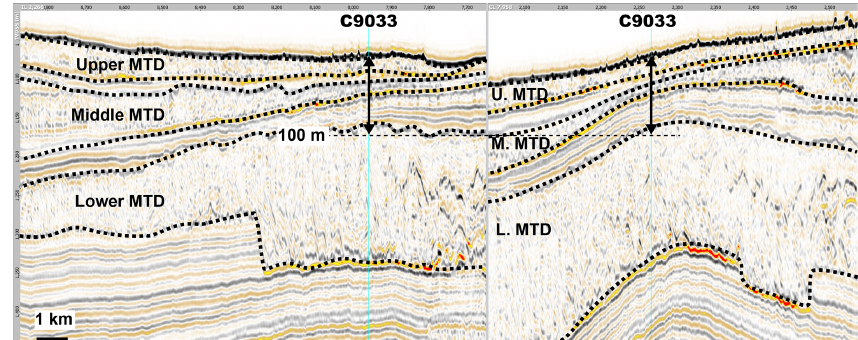
Figure 3. Seismic profiles at the drill site C9033 show transparent and/or chaotic intervals interpreted as mass transport deposits. There are three such intervals in the top 100m. Seismic profiles are from JOGMEC (2013,